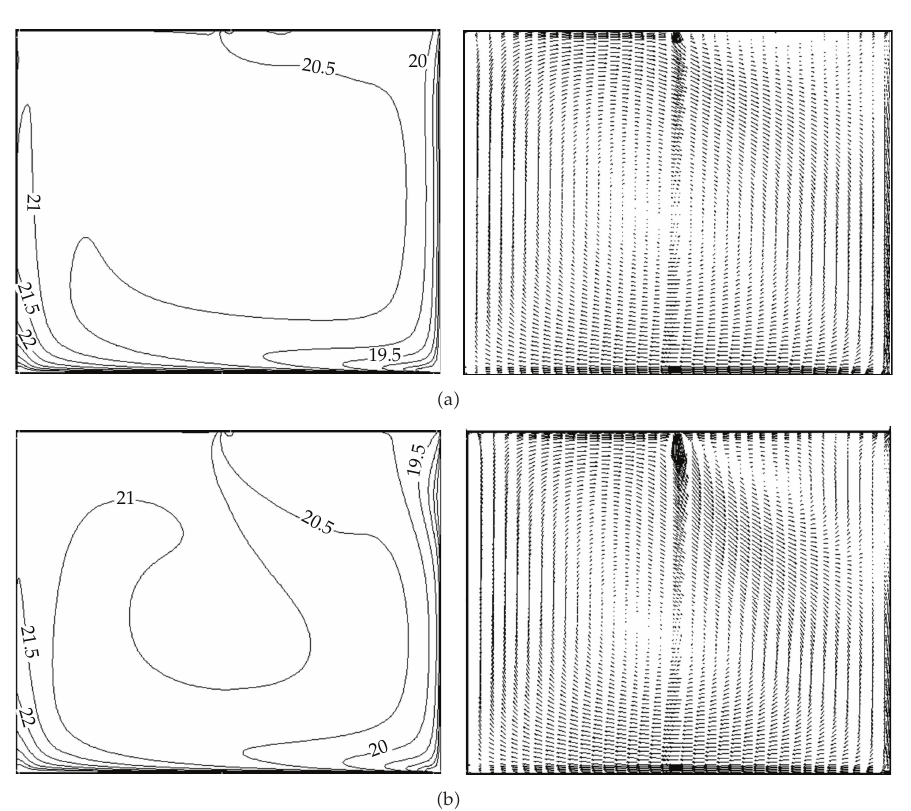
Figure 6: The velocity and temperature distributions for CSV at T fl (cid:8) 30 ◦ C, q ow (cid:8) − 100W/m 2 , (cid:5) a (cid:6) u in (cid:8) 0.3m/s, and (cid:5) b (cid:6) u in (cid:8) 0.9m/s.